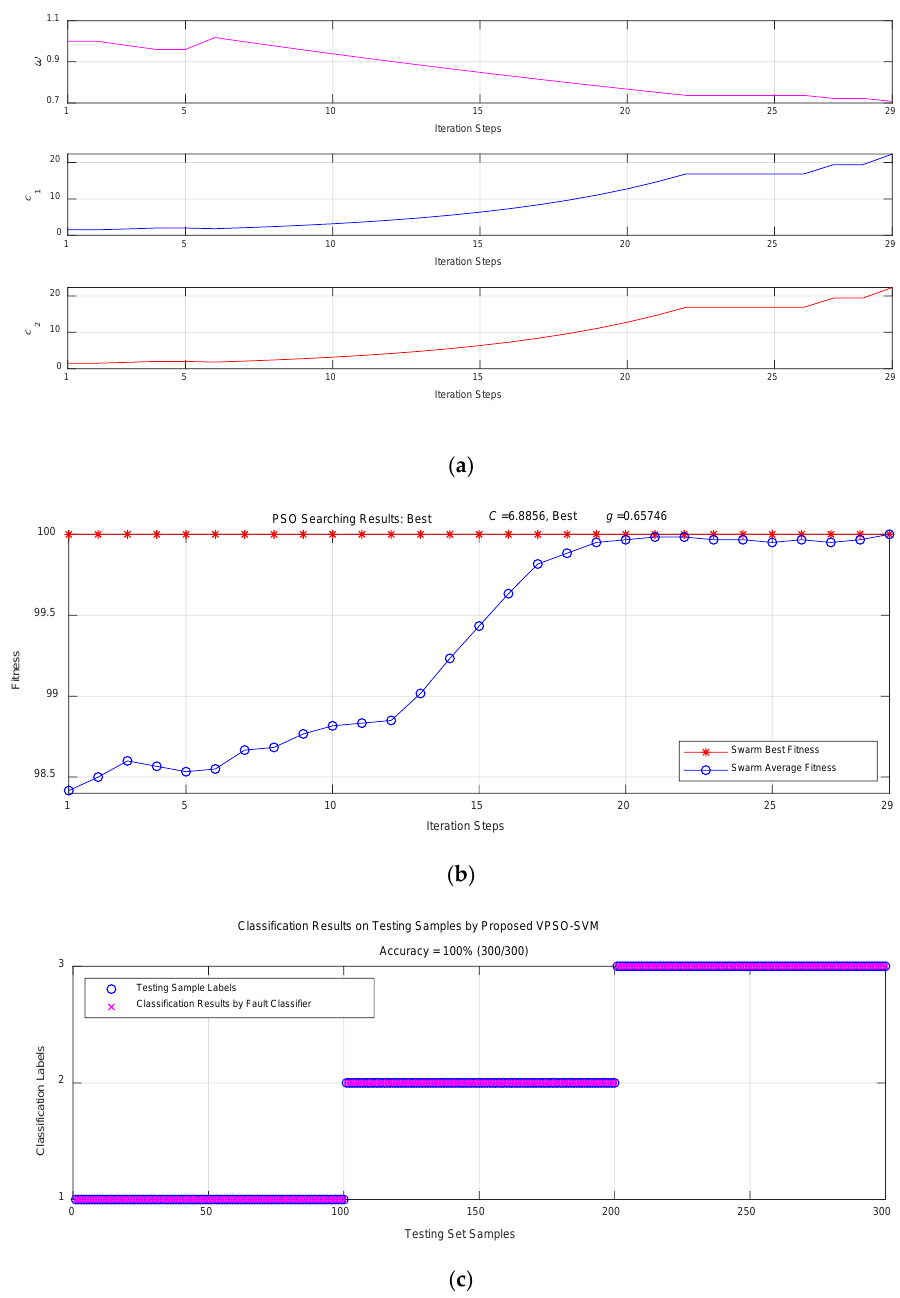
Figure 14. Fault classification results on testing set by VPSO-SVM with SVM parameters C = 6.8856 and g = 0.65746 optimized by CPSO. ( a ) Variation curves of c 1 , c 2 and ω in PSO along with iterations. ( b ) Swarm average fitness evolving process along iterations (29 iteration steps to converge with variable c 1 , c 2 and ω in PSO). ( c ) Fault classification results of VPSO-SVM with classification accuracy = 100%. Table 4. Simulation results statistical data of the three comparative methods. SVM CPSO-SVM VPSO-SVM Elapsed Time on Training (s) 0.001976 18.527162 8.469169 Classification Accuracy on Testing Set Samples 99.33% (correctly classified samples/total samples) PSO Iteration Steps